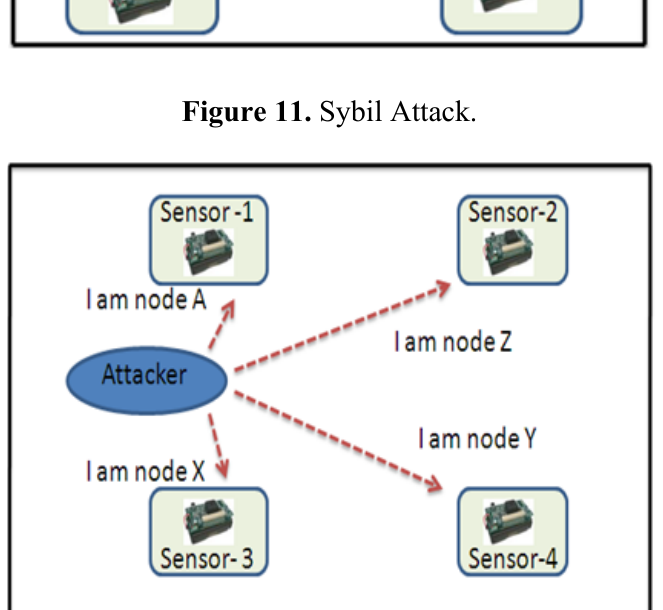
Figure 11. Sybil